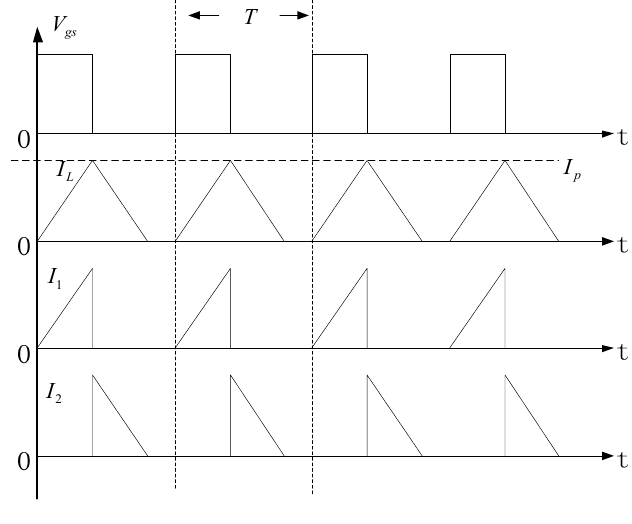
Figure 8. Current Figure 8. Current waveform.